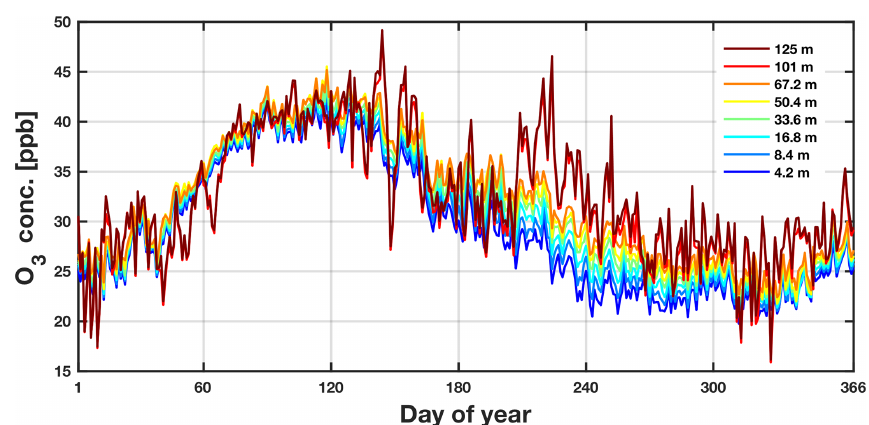
Figure 1. Daily medians of ozone concentrations at different heights for years 1996–2016. Heights are indicated by different colours.